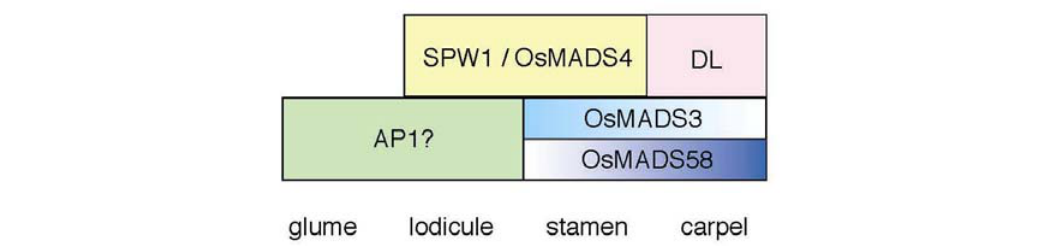
FIGURE 4. Current model of floral organ specification in